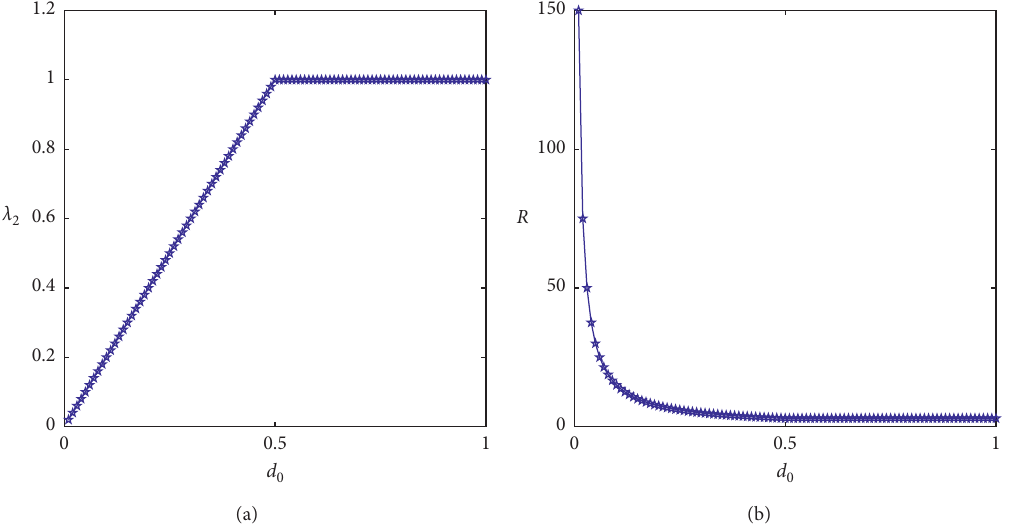
Figure 8: When N is even, the synchronizability of Network I changes with the interlayer coupling strength d changes with d ( d changes from 0.01 to 1); (b) R changes with d 0 0